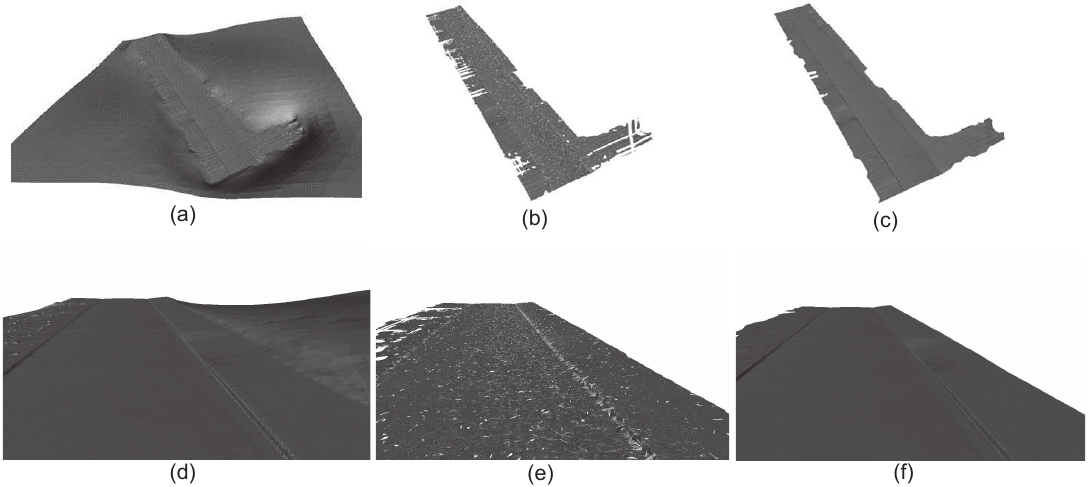
Figure 6: Comparison between surface reconstruction methods obtained for the dataset Urban ♯ 1 : (a) Poisson method, (b) Greedy projection method, (c) AGSR method; (d) - (f): close-up views corresponding to the surface reconstructions results illustrated in Figures (a) -